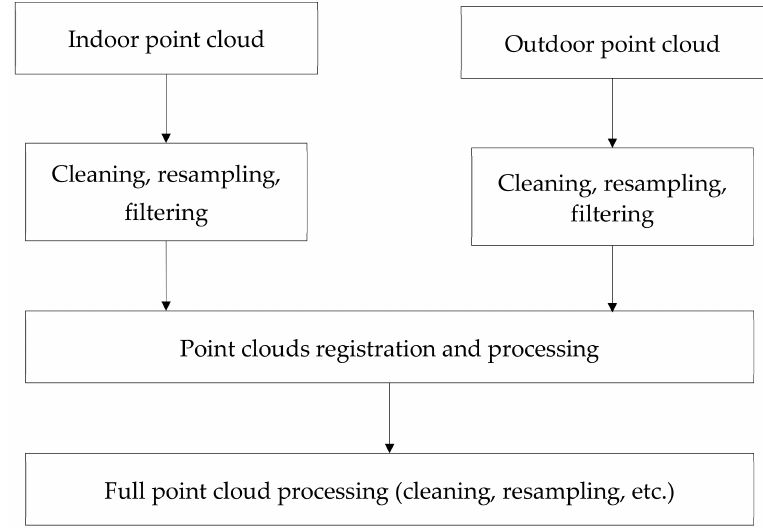
Figure 4. Point cloud processing.